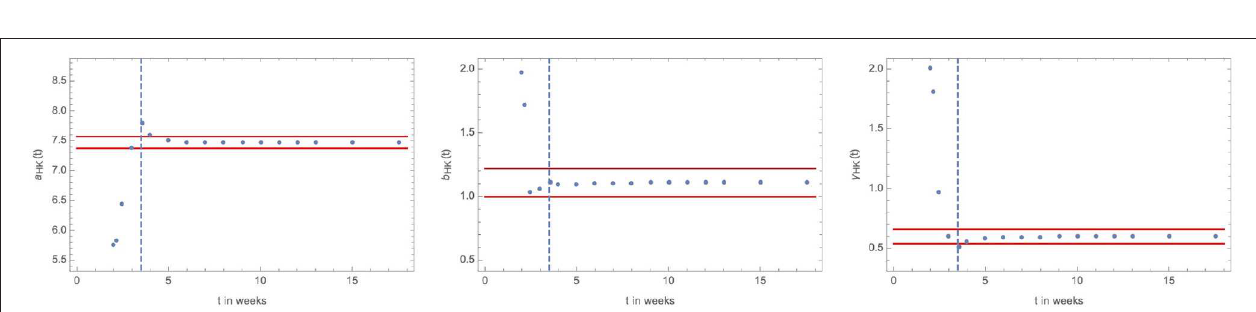
FIGURE 3 | Fit parameters to HK SARS-2003 data as function of time. (Left) a ( t ) with the red band corresponding to a change of 0.1 in the asymptotic value of a . This translates into a 10 % change in the asymptotic number of infected cases. (Center, Right) b ( t ) and γ ( t ) with the red band corresponding to a 10 % change in their asymptotic value. The vertical dashed blue line marks the occurrence of the inflection point in the infected cases.